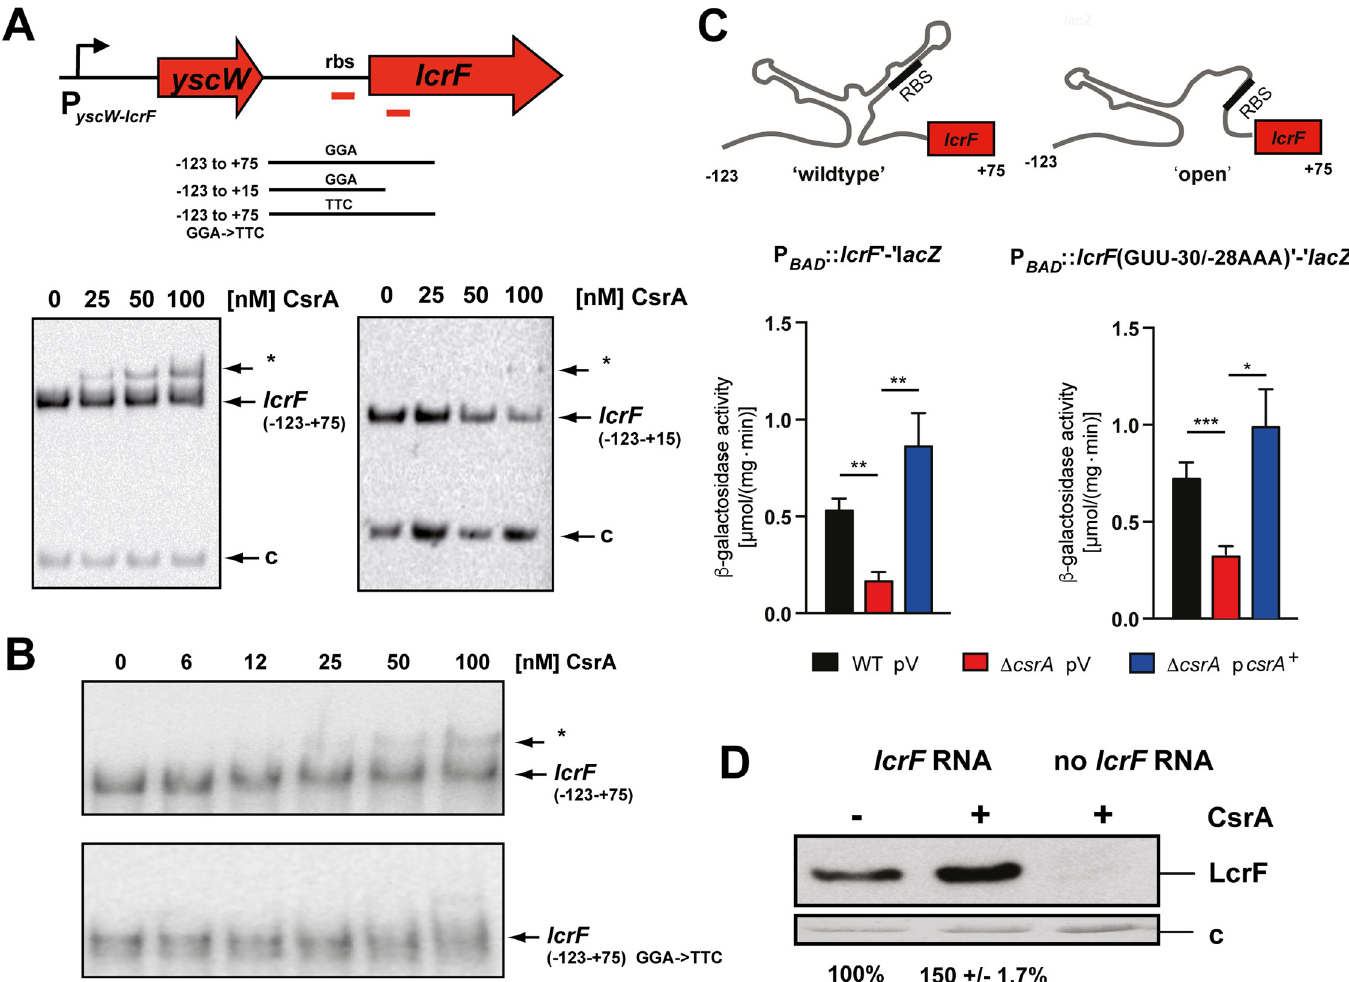
Fig 2. Influence of CsrA on lcrF transcript translation. (A) Upper panel: Overview of the yscW-lcrF locus and the generated lcrF transcripts used for the RNA binding assay below and in (B); red bars: CsrA binding sites. The yscW-lcrF promoter is indicated by a broken arrow; the identified CsrA binding sites are indicated with red bars. The numbers give the nucleotide positions with respect to the translation initiation site of lcrF . Lower panel: RNA binding assays with increasing concentration of purified CsrA-His 6 to lcrF transcripts harboring the region of position -123 to +75 (left panel) or -123 to +15 (right panel) with respect to the translational start site. The CsrA- lcrF mRNA complex is indicated by a star. c: hns control transcript. (B) The lcrF transcript (-123 to +75) and a mutant transcript in which the GGA motif is exchanged against TTC were incubated with increasing concentration of purified CsrA-His 6 . The CsrA- lcrF mRNA complex is indicated by a star. (C) To study CsrA influence on translation initiation of lcrF , expression of an arabinose inducible translational lcrF-lacZ fusion encoded on pKB14 and a mutant variant with an open lcrF RNA thermometer element encoded on pKB99 was analyzed in YPIII (WT) pV (empty cloning vector pHSG576) and YP53 ( Δ csrA ) pV and YP53 pKB60 ( csrA + ). The bacteria harboring the different lcrF-lacZ fusions were grown at 25˚C to exponential phase and were then shifted for 4 h to 37˚C in the presence of 0.1% arabinose and absence of Ca 2+ . β -galactosidase activities represent the mean ± SD from three independent biological replicates which were analyzed with Student’s t-test. � : P < 0,05: �� : P < 0,01, ��� : P < 0,001. (D) An amplified lcrF DNA fragment of pMP1 was used for in vitro transcription. The resulting lcrF mRNA fragment was used for in vitro translation in the absence or presence of CsrA. Samples were analyzed by western blotting with a polyclonal antibody directed against LcrF. An assay without the lcrF template RNA was used as negative control. c: loading control (lower